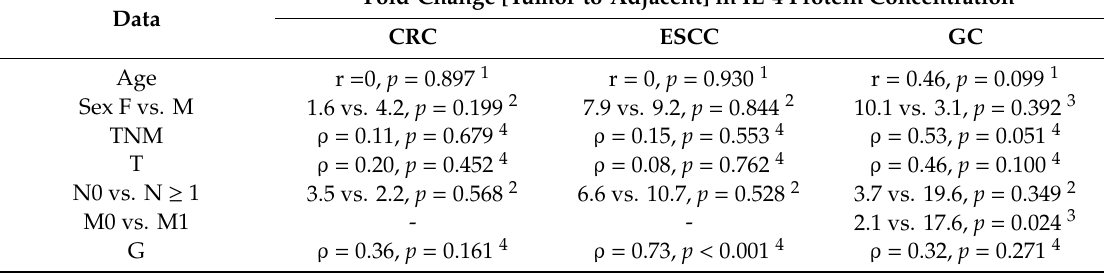
Table 3. Association of demographic and pathological data with IL-4 protein concentration in the GIT cancer patients.